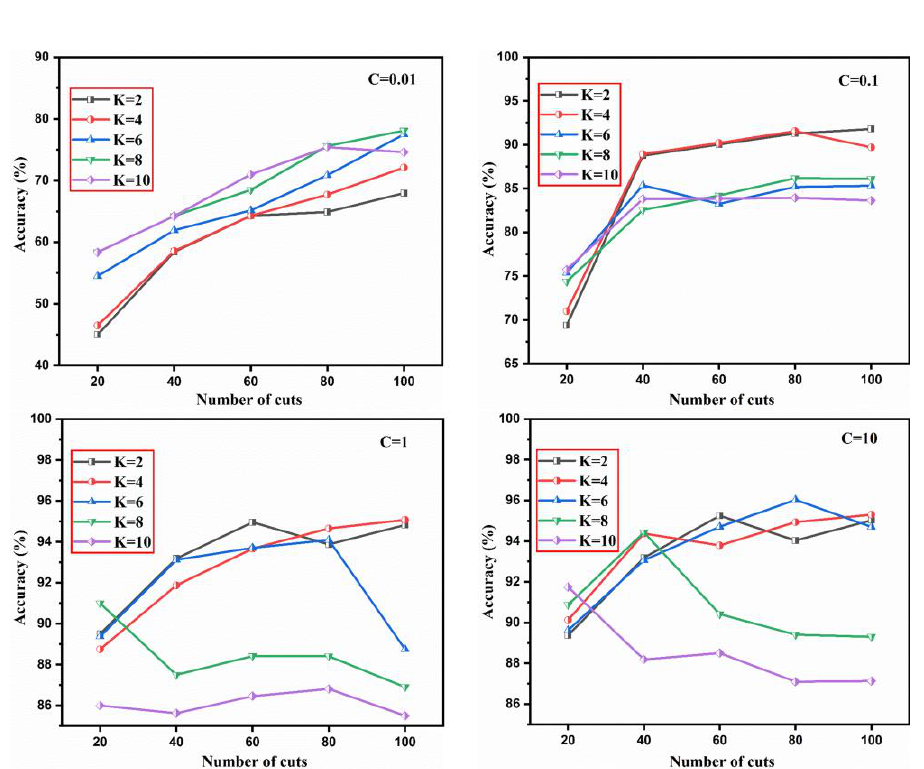
Figure 5. Accuracy percentage achieved with K-mer-based SVM model with different parameters. The RF method is made up of a group of trees, each of which is built using randomly collected data with the same statistical distribution as the trees in the forest [38]. Voting is often used to decide class labels in the forest tree for classification. We used the different n_estimators values (20, 40, 60, 80, 100) and max_depth values (10, 20, 30, 40, 50) to determine which gives the best classification accuracy. Finally, 97.18 ± 0.4% of the accuracy result was achieved at n_estimators = 100 and max_depth = 50. The average precision, recall, and F-score value for the K-mer-based RF model were 0.9718 ± 0.004, 0.9718 ± 0.004, and 0.9718 ± 0.004. Figure 6 shows the accuracy results for the K-mer-based RF model with various numbers of cuts, different subsequence lengths, various n_estimators, and max_depth values.